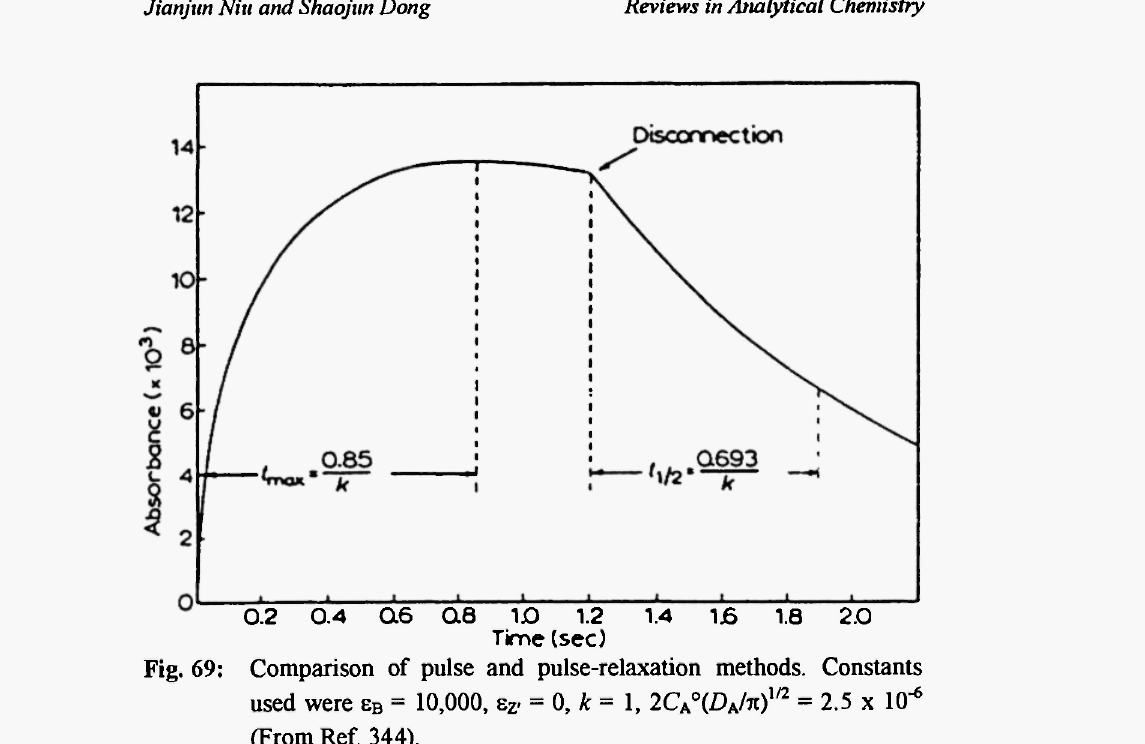
Fig. 69: Comparison of pulse and pulse-relaxation methods. Constants used were ε Β = 10,000, ε ζ - = 0, k = 1, 2C A °(D A /n) m = 2.5 χ 10" 6 (From Ref.